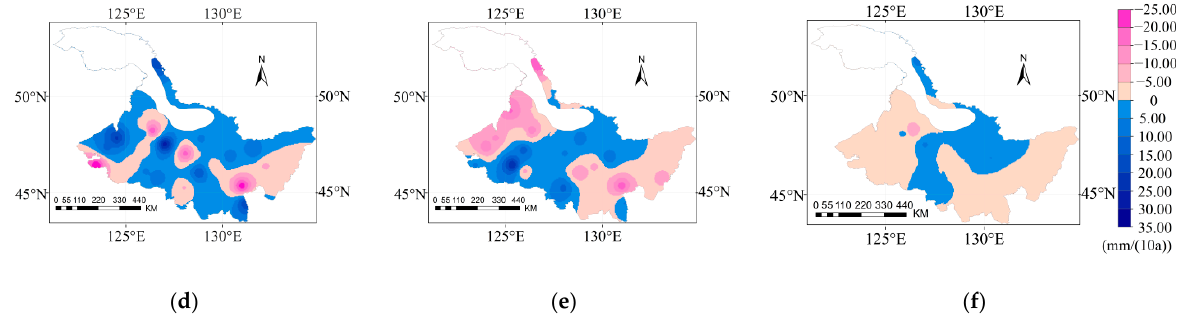
Figure 13. Climate tendency rates of I r in the periods ( a ) 2021–2050, ( b ) 2051–2080, and ( c ) 2021–2080 under RCP4.5, and in the periods ( d ) 2021–2050, ( e ) 2051–2080, and ( f ) 2021–2080 under RCP8.5 during the soybean growth period.